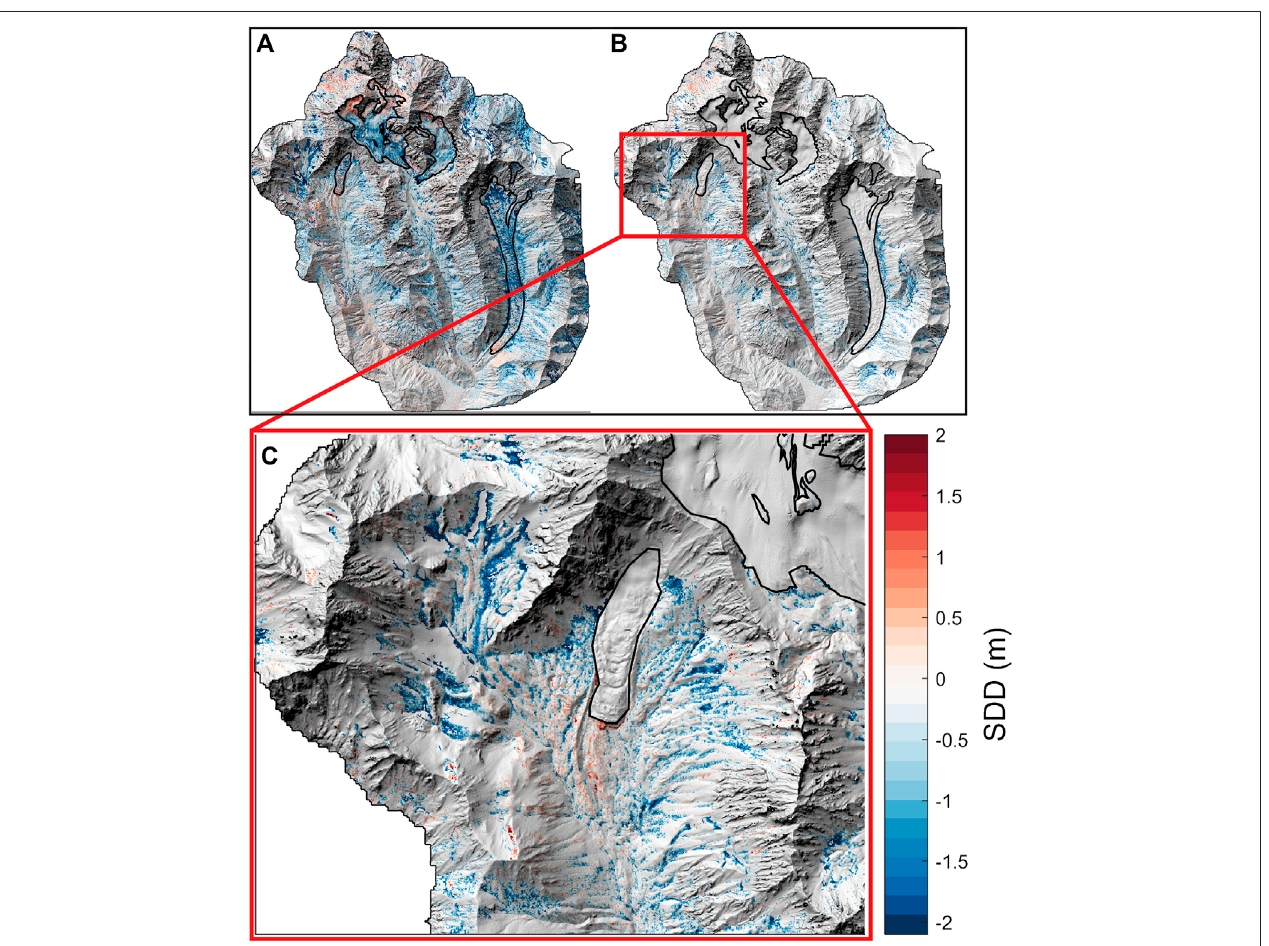
FIGURE9| Amapofthesnowdepthdifference[snowdepthdifference(SDD-m)]forallpixels (A) andtherestrictedchangesthatexcludei)glacierareas,ii)areasof saturation and iii) differenceswithin the uncertainty of thetopographic indices (B) .SDD (2019 – 2017) is shown in a range of − 2 to+2 m whereby negative values indicate that 2019 had less snow depth. Panel C shows the zoomed panel in a subregion to highlight the detail of pixel-to-pixel differences. Gray areas in panel A are associated with no snow and in B,C where changes are ignored due to the above criteria.